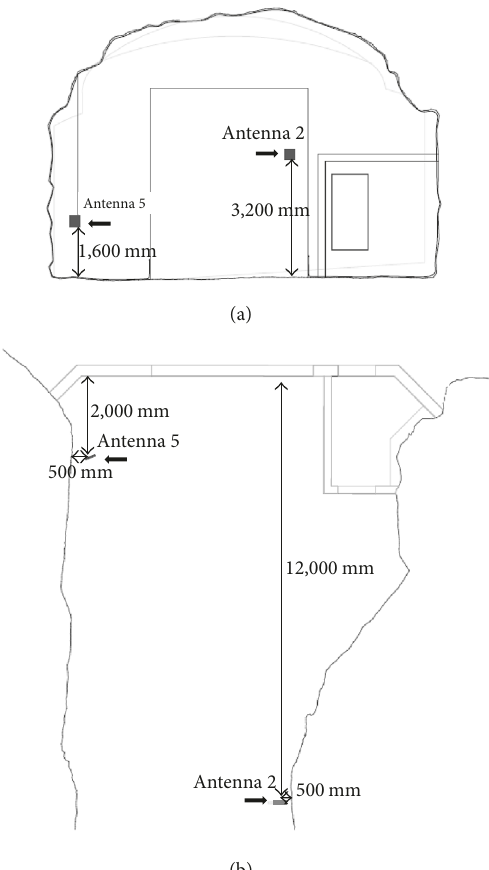
Figure 9: The front side of the concrete wall at pole 150 with antennas 2 and 5 (a) and the top side of the concrete wall at pole 150 with antennas 2 and 5